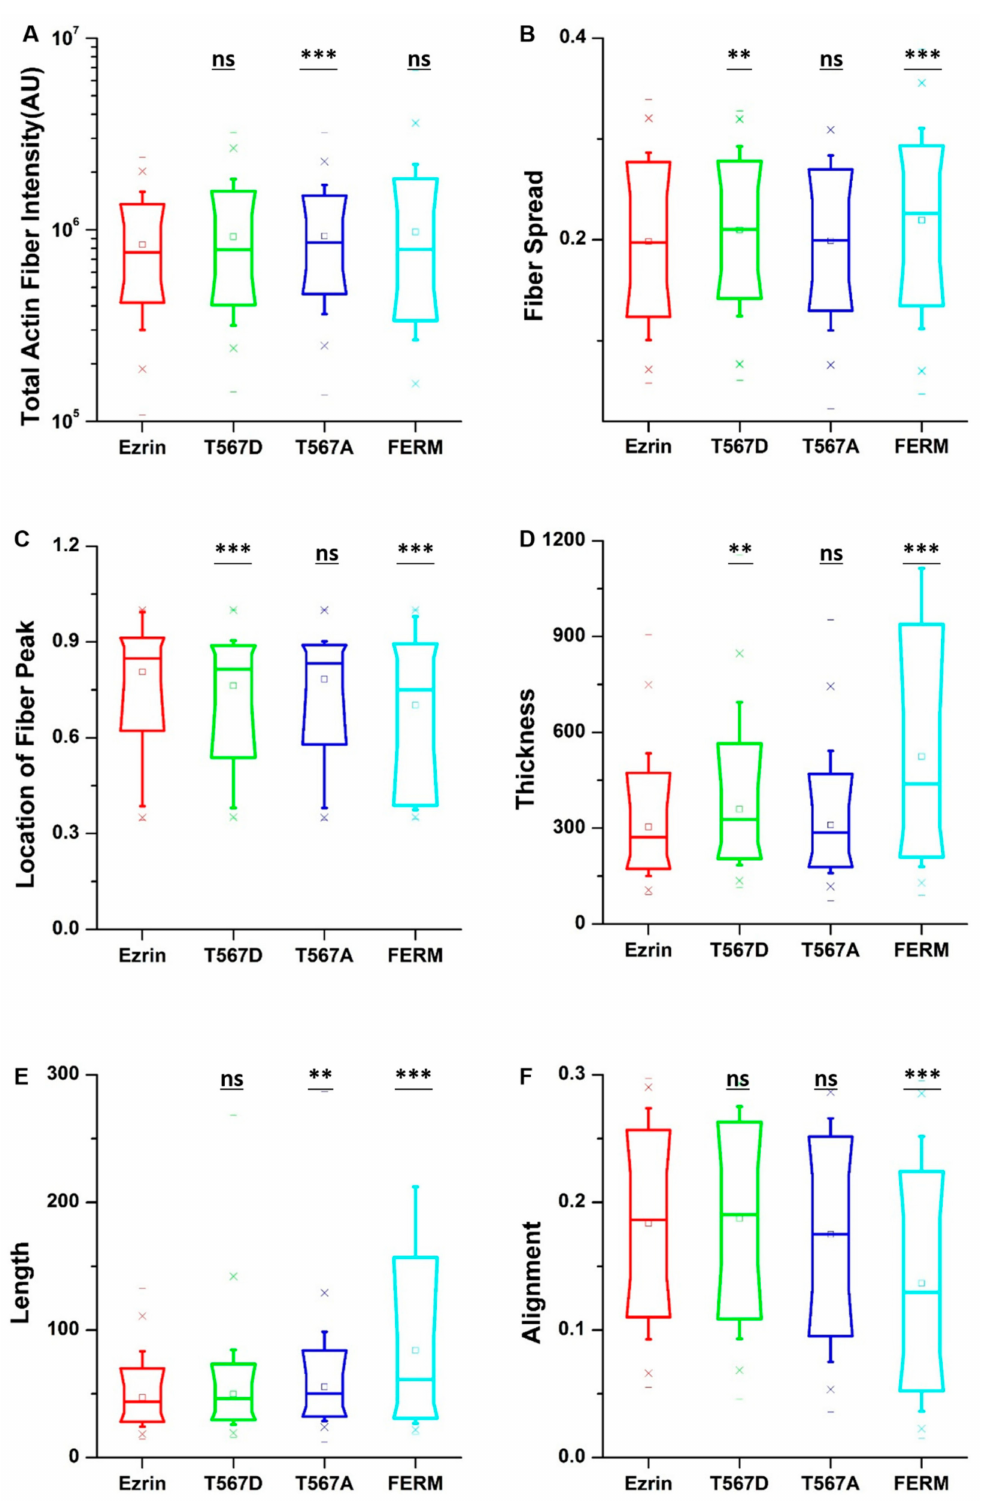
Figure 4. The e ff ect of ezrin mutations on the actin cytoskeleton. Box plots show the results of the total actin fiber intensity ( A ), fiber spread ( B ), location of the fiber peak ( C ), fiber thickness ( D ), fiber length ( E ), and fiber alignment ( F ). A total of n = 420 (ezrin), n = 496 (ezrin T567D), n = 1235 (ezrin T567A), and n = 562 (FERM) cells were analyzed from n = 6 repeats. Box plots extend from the 10th to the 90th percentile, whiskers from the 5th to the 95th. Asterisks indicate a statistical di ff erence (** p < 0.01, *** p < 0.001, obtained using Dunnett’s test against wild-type